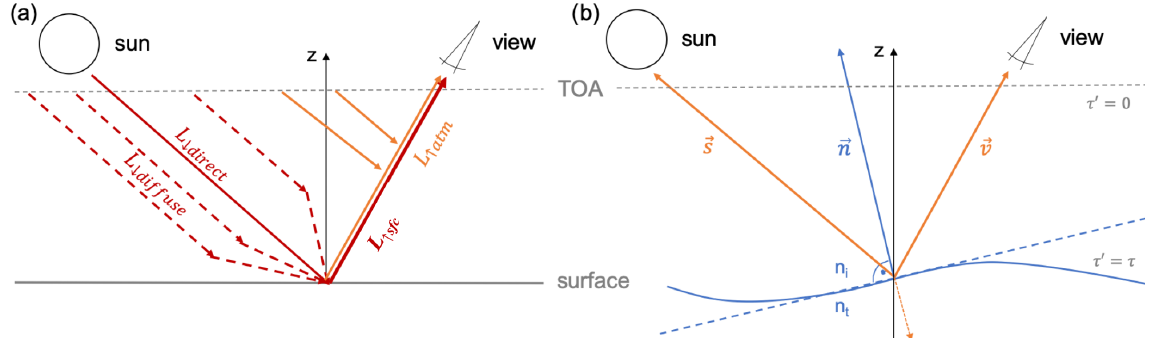
Figure A1. Sketches of the simple clear-sky model. (a) The main radiance components and (b) the geometry setup based on the vectors s pointing into the Sun, v pointing to the sensor, and the wave facet normal n